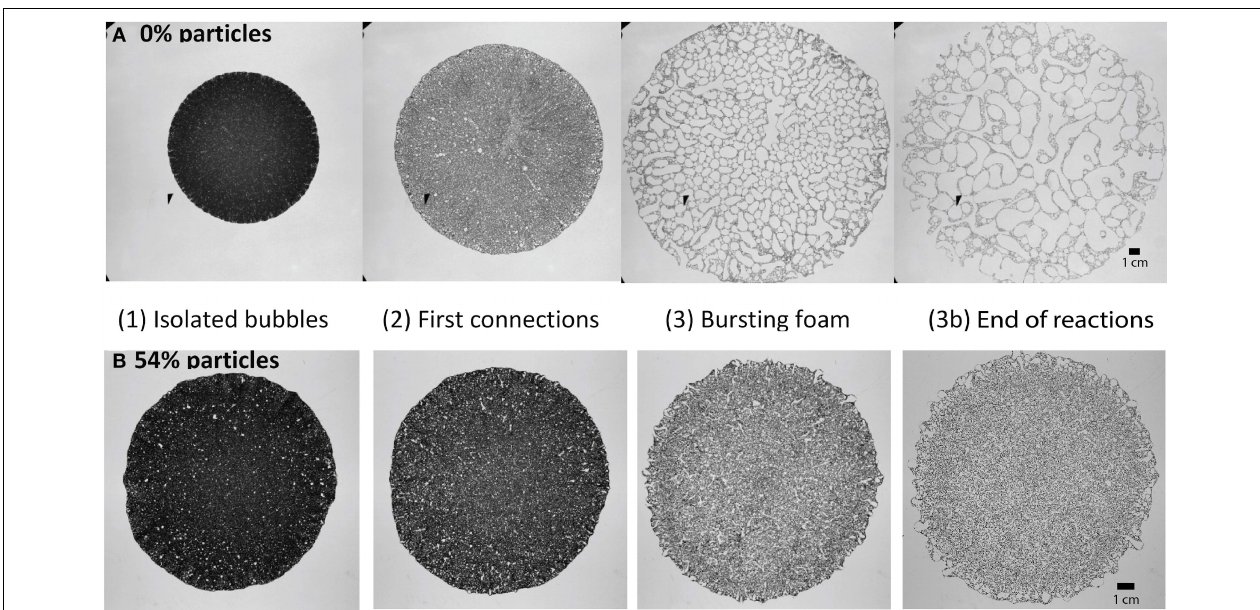
FIGURE 7 | Four phases of foam build-up for (A) a particle free experiment, and (B) a particle rich experiment containing 54 vol% particles ( φ ≈ 1). For all cases, syrup viscosity is 45–49 Pa s. Videos of these two experiments are available in Supplementary